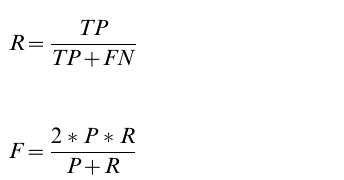
Table 5. Mean F-score for three frequency